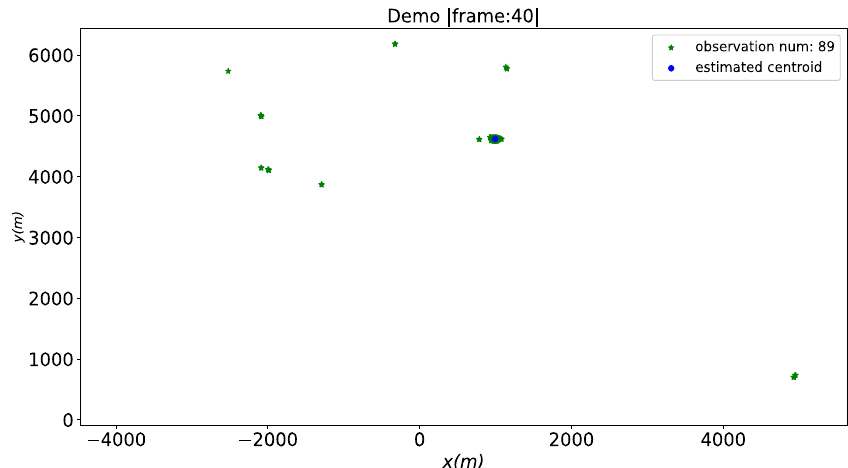
Figure 10. Single target in the Cartesian coordinate system tracking in the 40th frame.